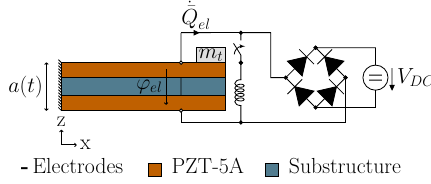
Fig. 3 Bimorph electromechanical structure coupled to an SSHI cir- cuit